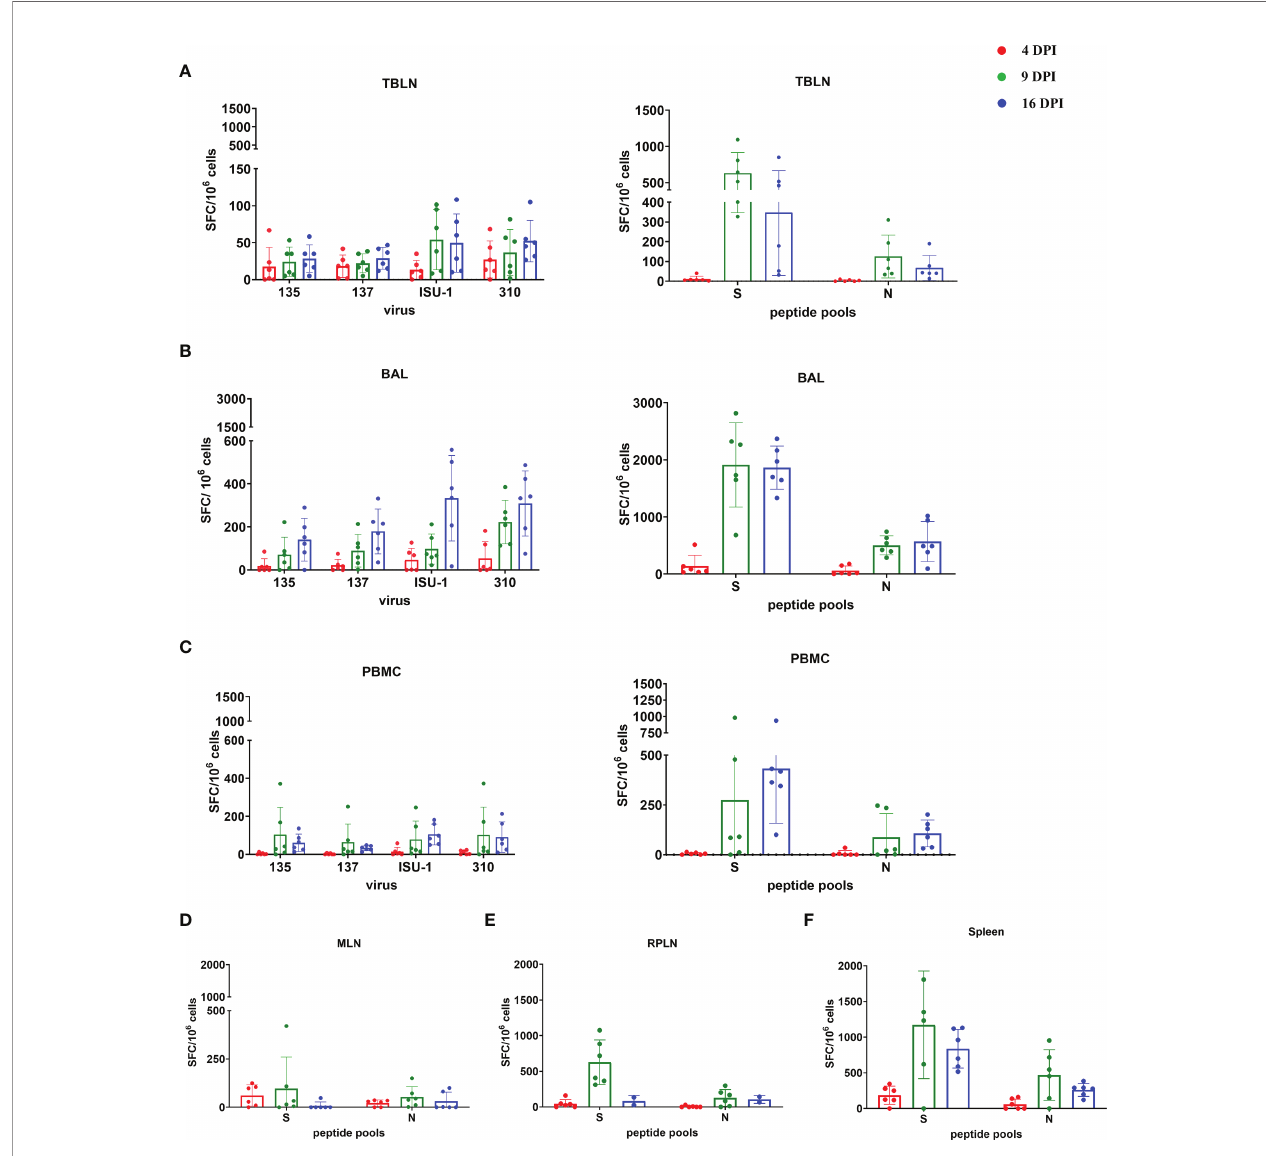
FIGURE 7 | IFN g ELISpot responses in tissues after in vivo challenge with PRCV 135. IFN g secreting spot forming cells (SFC) were enumerated by ELISpot in tracheobronchial lymph nodes (TBLN) (A) , bronchoalveolar lavage (BAL) (B) , PBMC (C) , mesenteric lymph nodes (MLN) (D) , retropharyngeal lymph nodes (RPLN) (E) and spleen (F) at 4, 9 and 16 DPI, following stimulation with 135, 137, ISU-1 or 310 viruses or pools of peptides covering S and N proteins. Each symbol represents an individual animal, the top of the bar the mean and the line the standard deviation